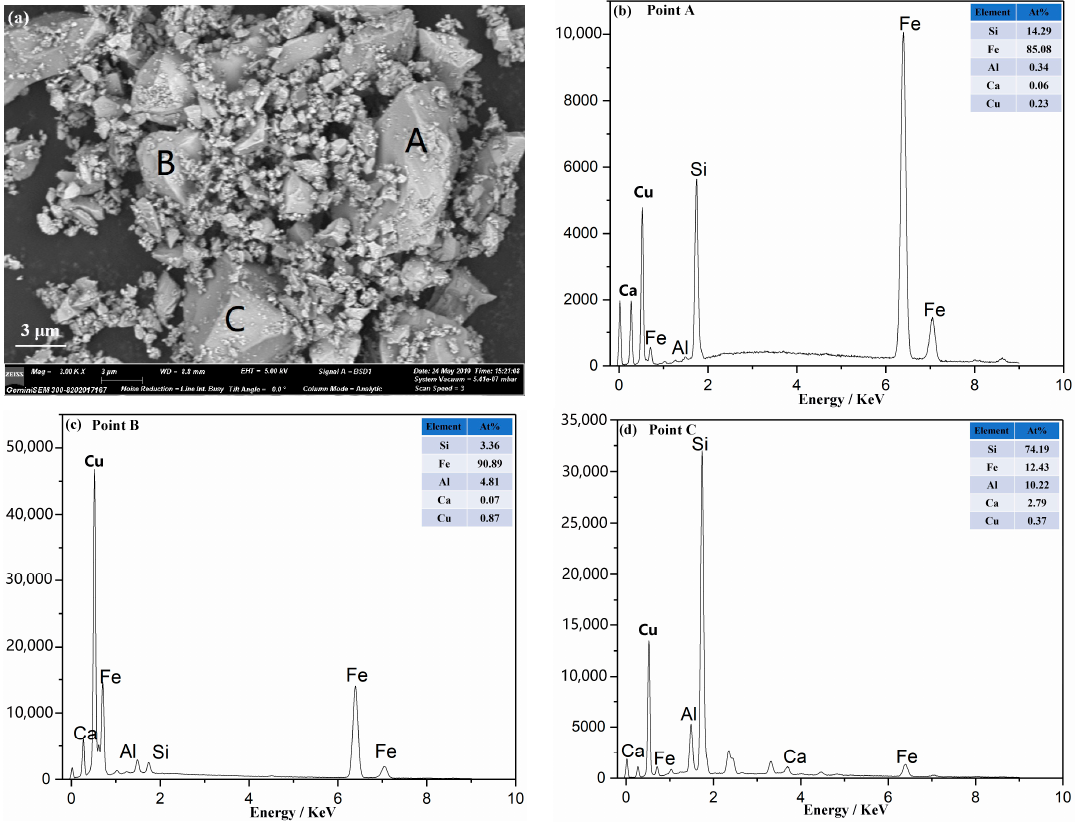
Figure 2. The SEM micrograph of copper slag ( a ), the EDS result of point A ( b ), the EDS result of point B ( c ), and the EDS result of point C ( d ).